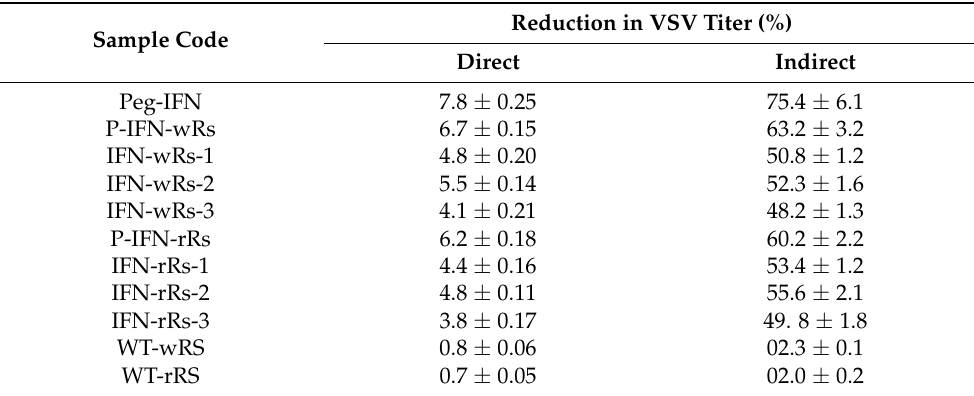
Table 1. The recombinant IFN- α 2a protein antiviral